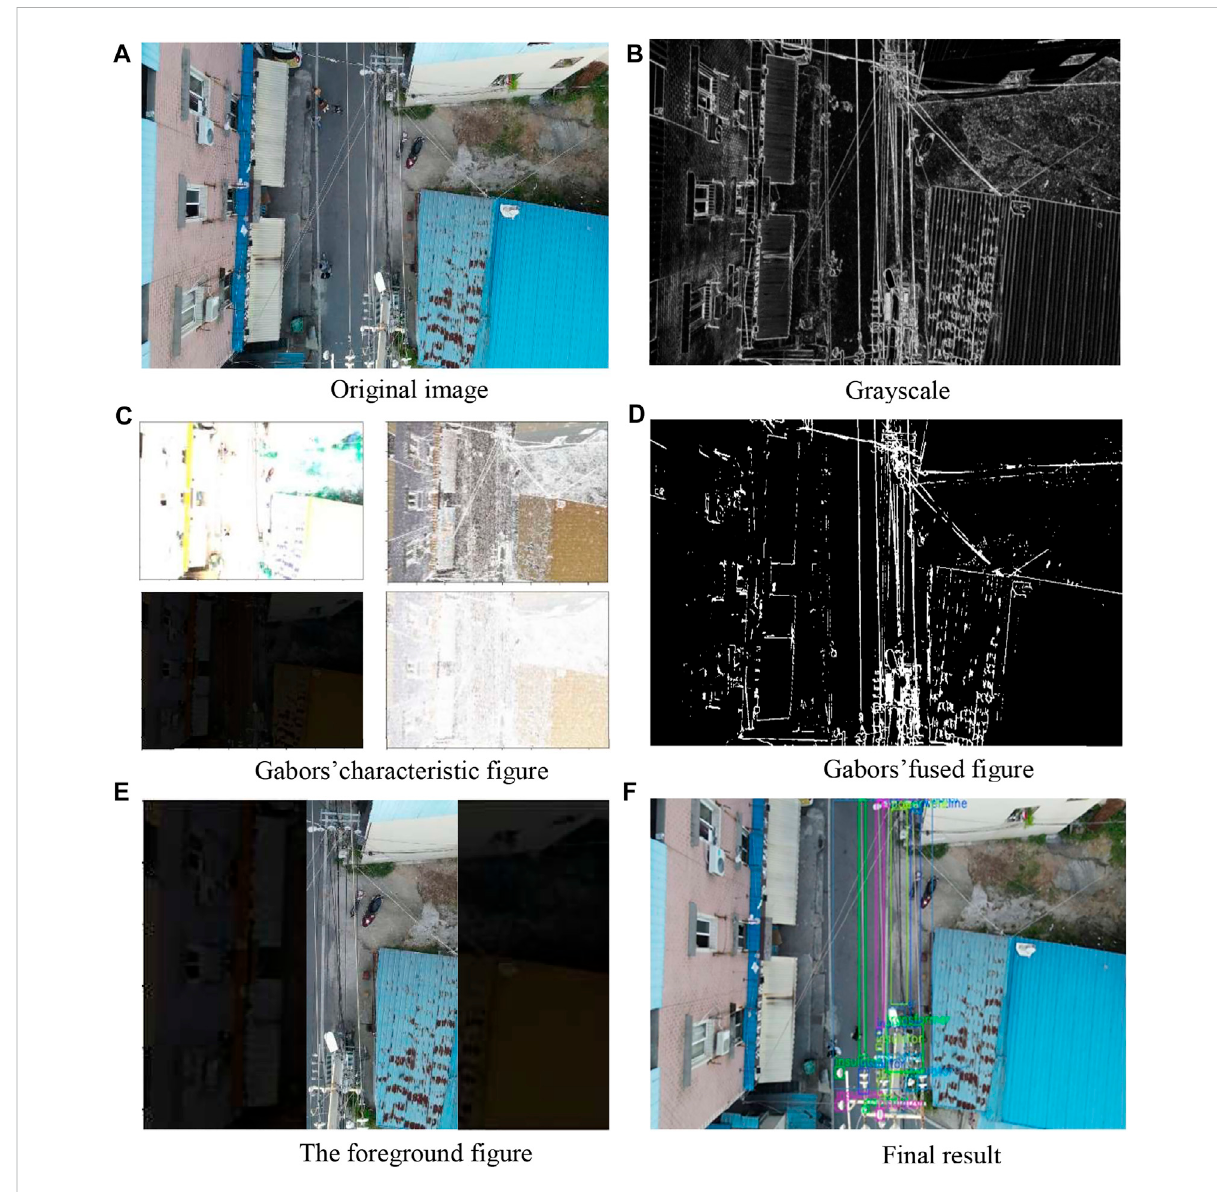
FIGURE 7 Results of each step in our